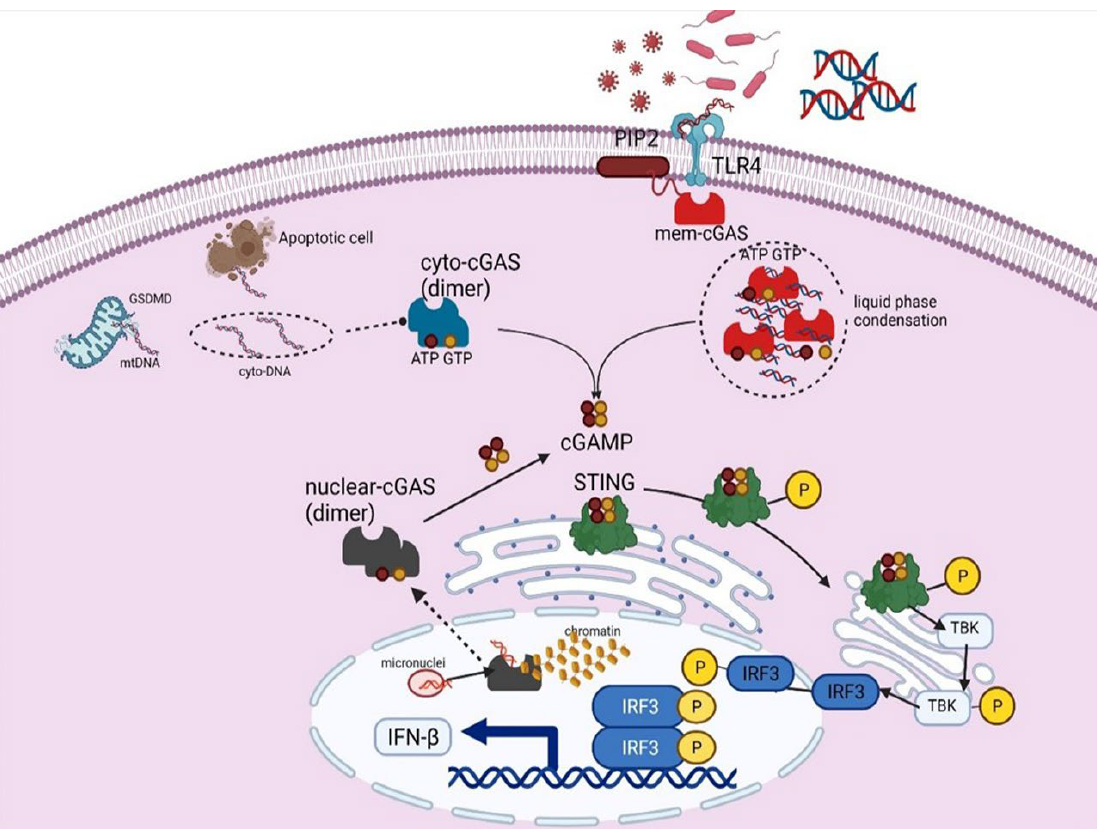
Figure 2. cGAS localization and signaling. cGAS is present in all the cellular compartments of the cell (membrane, cytosol, and nucleus). The positively charge N-terminal of cGAS binds with the negatively charged PIP2 present in the plasma membrane. Upon sensing dsDNA from pathogens or mt DNA excreting to the cytosol by forming a pore in mitochondria by GSDMD or ds DNA liberating from apoptotic cell or ds DNA from micronuclei or during chromatin repair during mitosis, cGAS dimerize which result in the generation of cGAMP. cGAMP binds to STING. STING auto- phosphorylates and translocates to the Golgi, where it phosphorylates TBK. p -TBK phosphorylate IRF3 which after phosphorylation enters the nucleus and results in the generation of IFN- β.